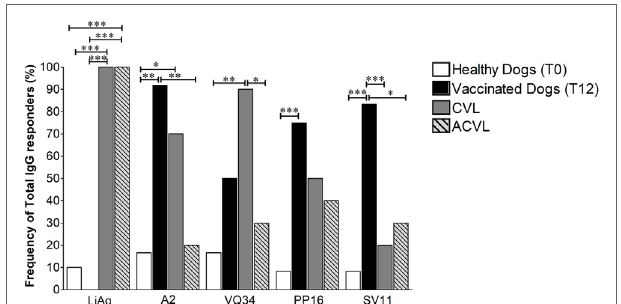
FigUre 4 | Frequency of total IgG responders observed in healthy controls (T0), vaccinated animals 1 year after immunization (T12) and in naturally infected canine visceral leishmaniasis symptomatic (CVL) and asymptomatic (ACVL) groups to LiAg, A2 protein (Leish-Tec ® ) and the three selected restricted B cell A2 protein peptides (VQ34, PP16, and SV11). The Chi squared test for proportions analyses was performed to determine statistical differences. * p < 0.05, ** p < 0.005, and *** p <